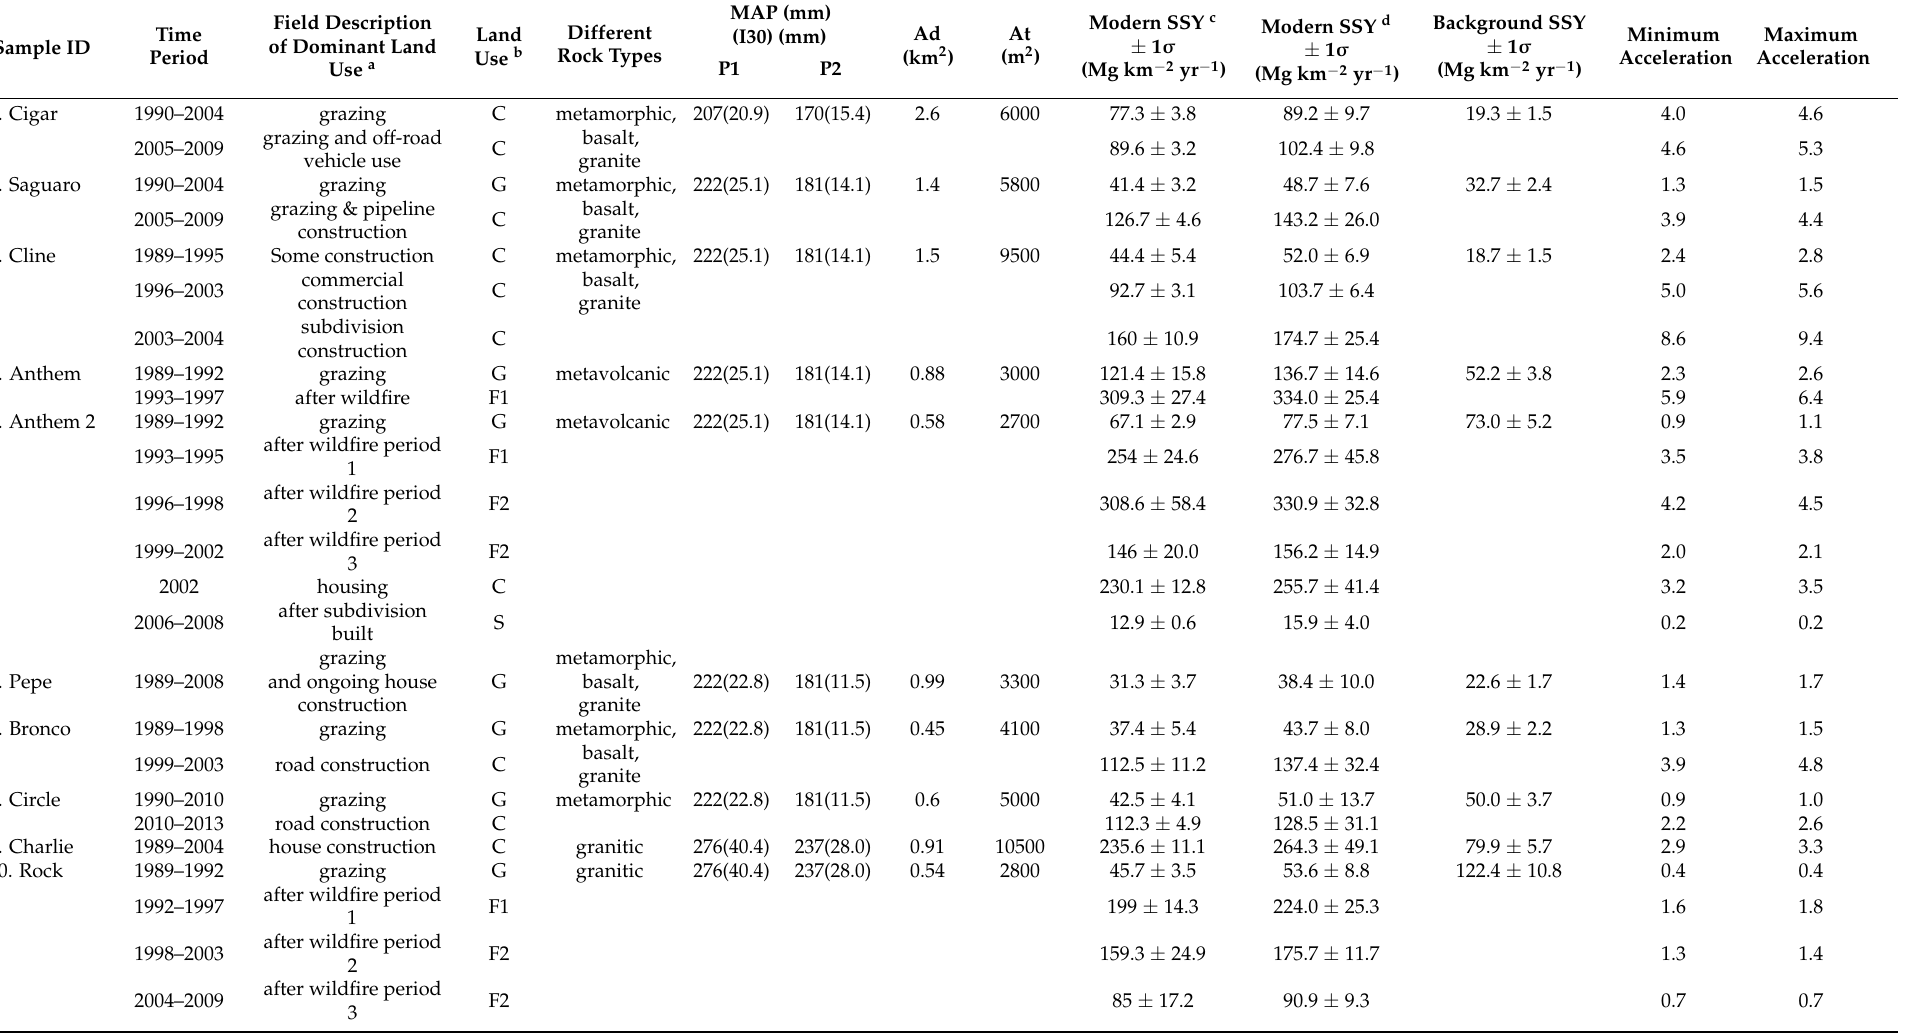
Table 6. Data on the stock tank catchments needed to calculate soil erosion, along with other watershed characteristics used in modeling soil erosion for the Phoenix metropolitan region (PMR). The last two columns (maximum and minimum acceleration) are a ratio of modern SSY to background SSY (from Table 3).